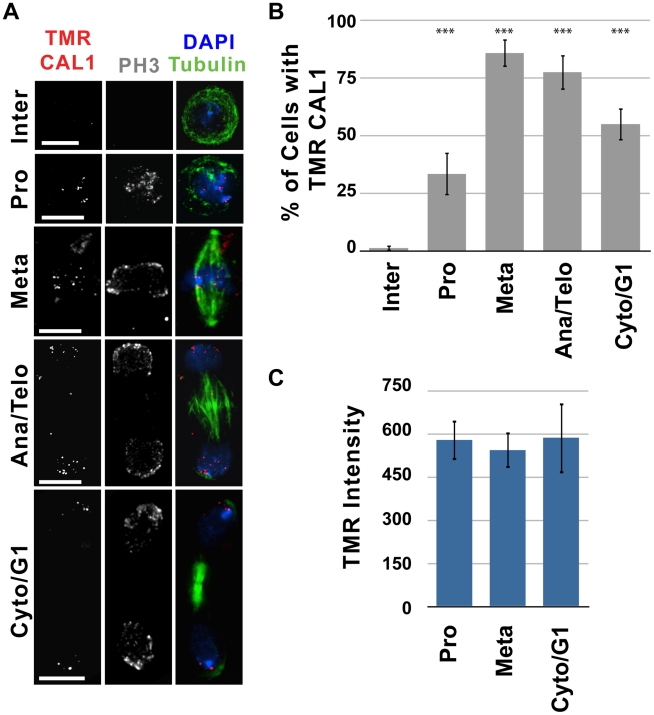
New CAL1 is first detectable during prophase in S2 cells.Quench-pulse-chase experiments were carried out as illustrated in Figure 2A. A) Representative images showing recruitment of newly-synthesized CAL1 (TMR, red) to centromeres 2 h after the BTP-block. TMR-CAL1 is absent in interphase (Inter), but is visible in prophase (Pro), anaphase/telophase (Ana/Telo) and cytokinesis/G1 (Cyto/G1). IF with anti-tubulin (green), anti-phospho H3 (gray), and DAPI (blue) was used to identify specific mitotic stages. Bar = 5 µm. B) Average percent of interphase (n = 84), prophase (n = 27), metaphase (n = 35), anaphase/telophase (n = 31) cytokinesis/G1 (n = 51) cells displaying centromeric TMR-CAL1 1 h following the BTP-block (X axis = cell cycle stage, Y axis = percent of cells positive for TMR labeling). New CAL1 recruitment is visible within the first hour following BTP-block in mitotic cells, and is first visible in prophase (*** p<0.0001 compared to interphase, Fisher's exact test). C) Quantitative comparison of the total TMR-CAL1 intensity at centromeres in prophase (n = 13) metaphase (n = 9) and cytokinesis, (n = 12). TMR intensity did not change significantly with mitotic progression (p = 0.9226, One-way ANOVA), suggesting that new CAL1 incorporation occurs mainly in prophase. Error bars represent standard error.